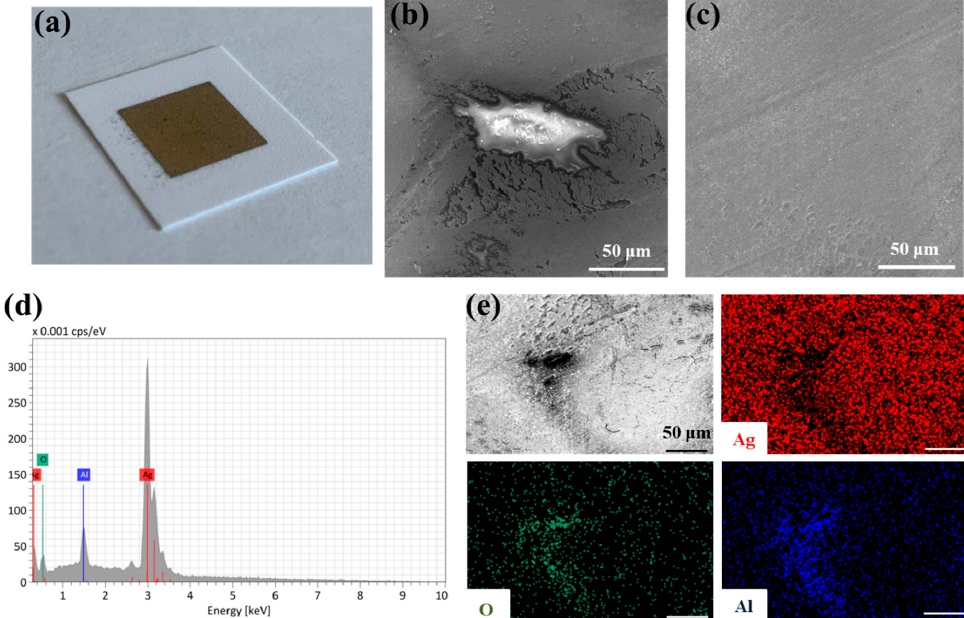
Figure 11. ( a ) Image of the printed silver feature on a glossy paper substrate before annealing, and SEM micrographs of the thin-film surface ( b ) before and ( c ) after IPL annealing; ( d ) EDX spectra and ( e ) elemental mapping of the as-prepared conductive features. Magnification 1000×; scale bar in all micrographs is 50 μ m.